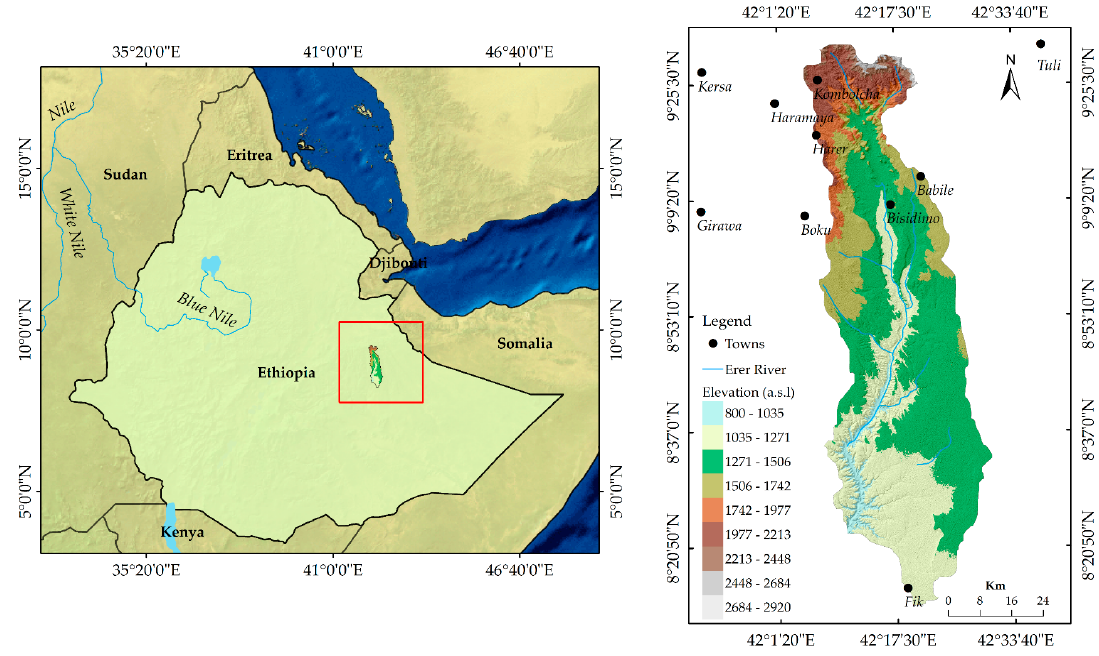
Figure 1. Location of the Erer Sub-Basin, North East Wabi Shebelle Basin, Ethiopia.